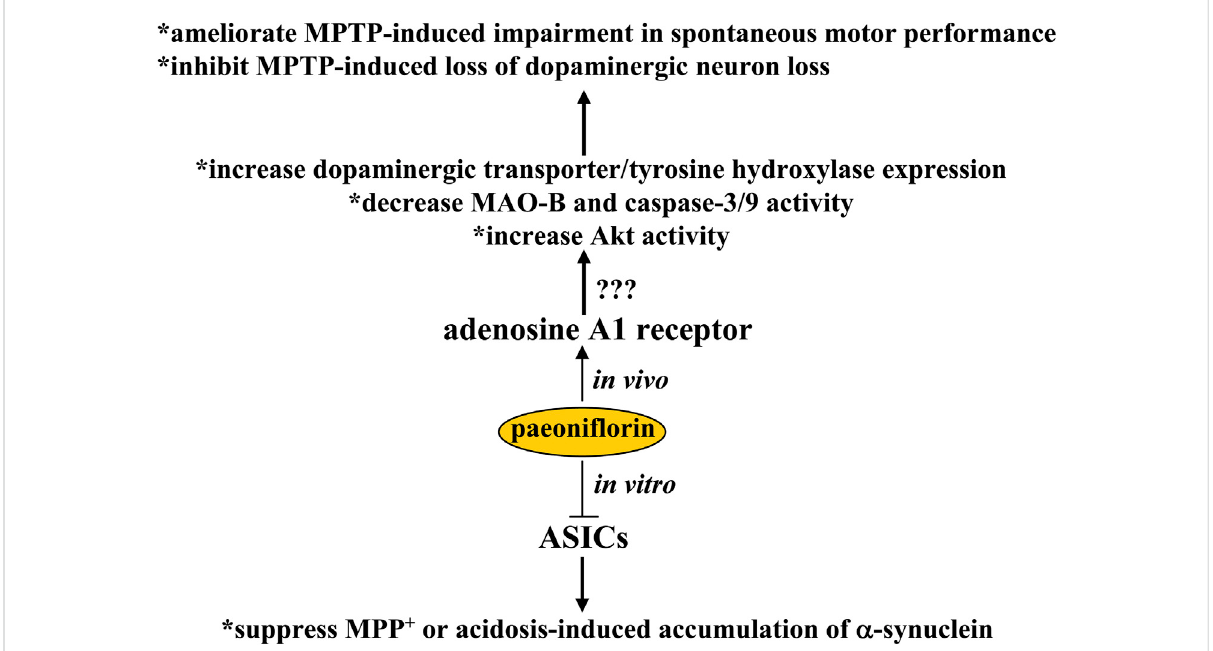
Effects and mechanisms of paeoni fl orin in Parkinson ’ s disease. Paeoni fl orin administration may ameliorate MPTP-induced impairment of spontaneous motor performance and inhibit MPTP-induced loss of dopaminergic neuron loss by increasing the expression of dopaminergic transporters and tyrosine hydroxylases, decreasing MAO-B and caspase-3/9 activity, or increasing Akt activity via a possible mechanism related to adenosine A1 receptor activation. Under in vitro conditions, paeoni fl orin was found to suppress MPP + or acidosis-induced accumulation of α - synuclein in cultured PC12 cells by inhibiting the activity or expression of ASICs. However, whether this in vitro effect on ASICs could mediate the neuroprotective effect of paeoni fl orin in animal models of Parkinson ’ s disease remains